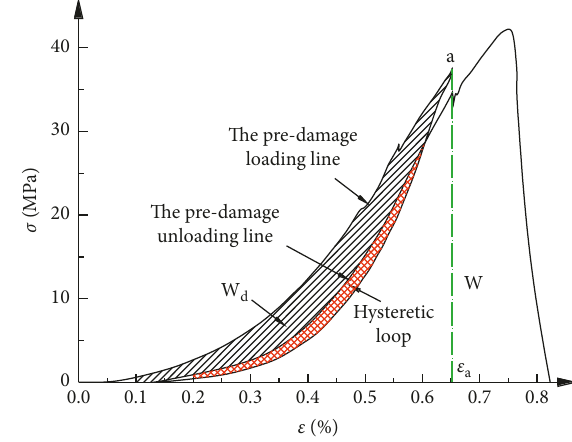
Figure 10: Strain energy calculation